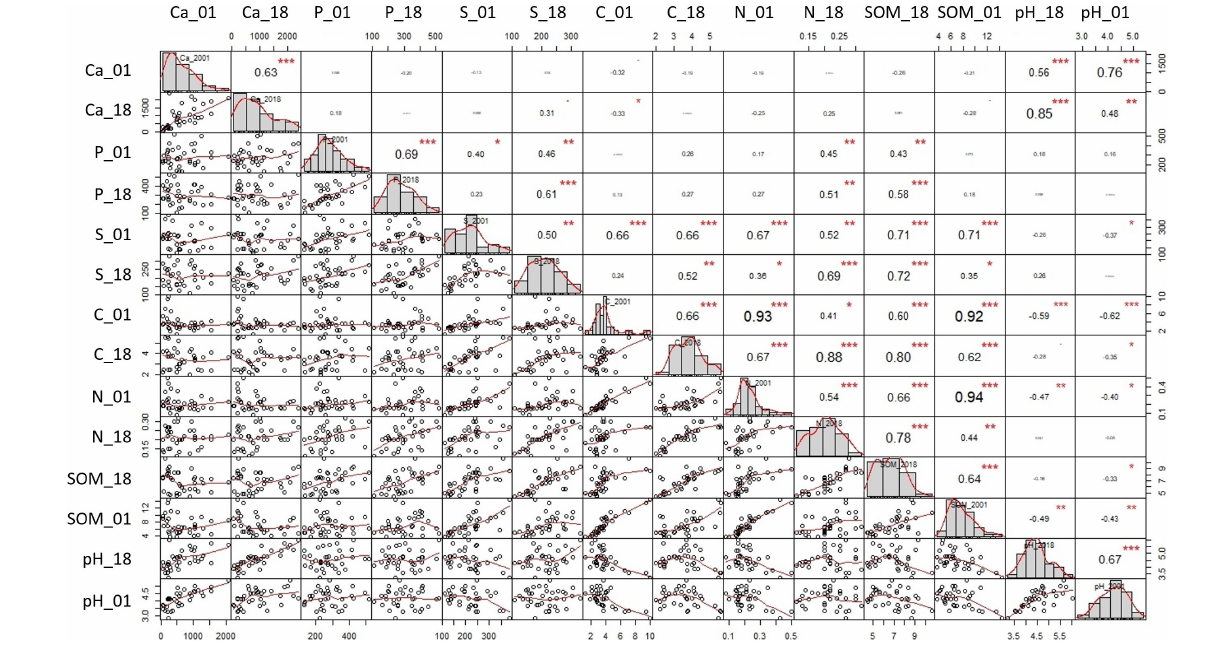
FIGURE 5 | Summary of all surface soil variables collected in 2001 (_01) and 2018 (_18) at the plot level ( n = 36). Diagonal: histograms showing variability of each dataset. Lower left: correlation among all variables. Upper right: Pearson’s correlation coefficient. Significant correlations are in bold; *, **, and *** indicate P : < 0.05. < 0.01, and < 0.001,